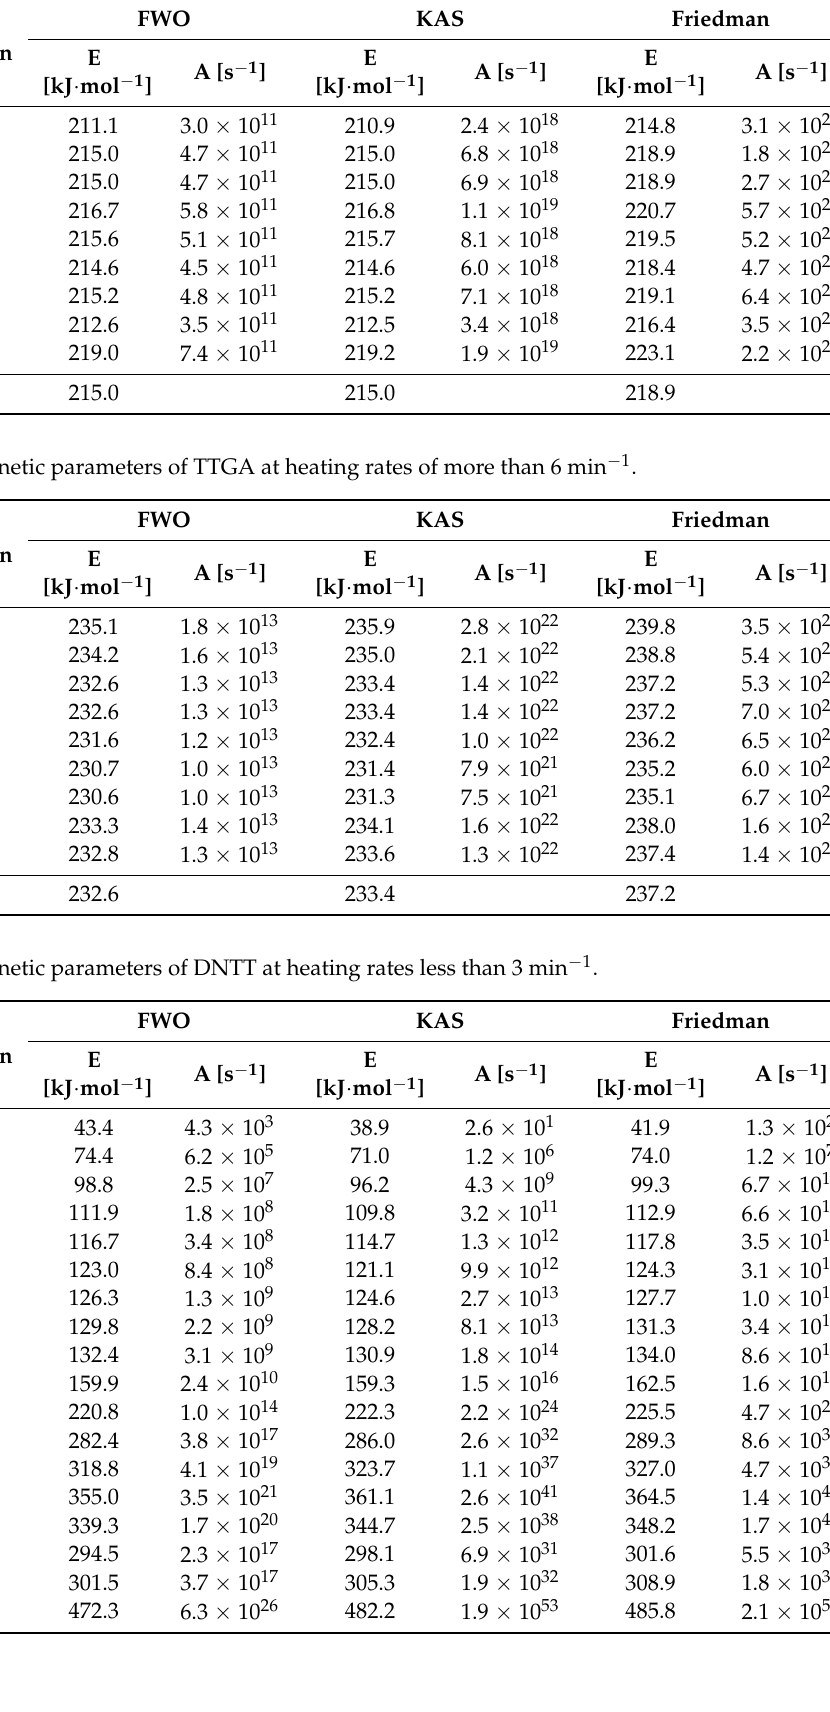
Table 11. Kinetic parameters of TTGA at heating rates less than 6 min − 1 .